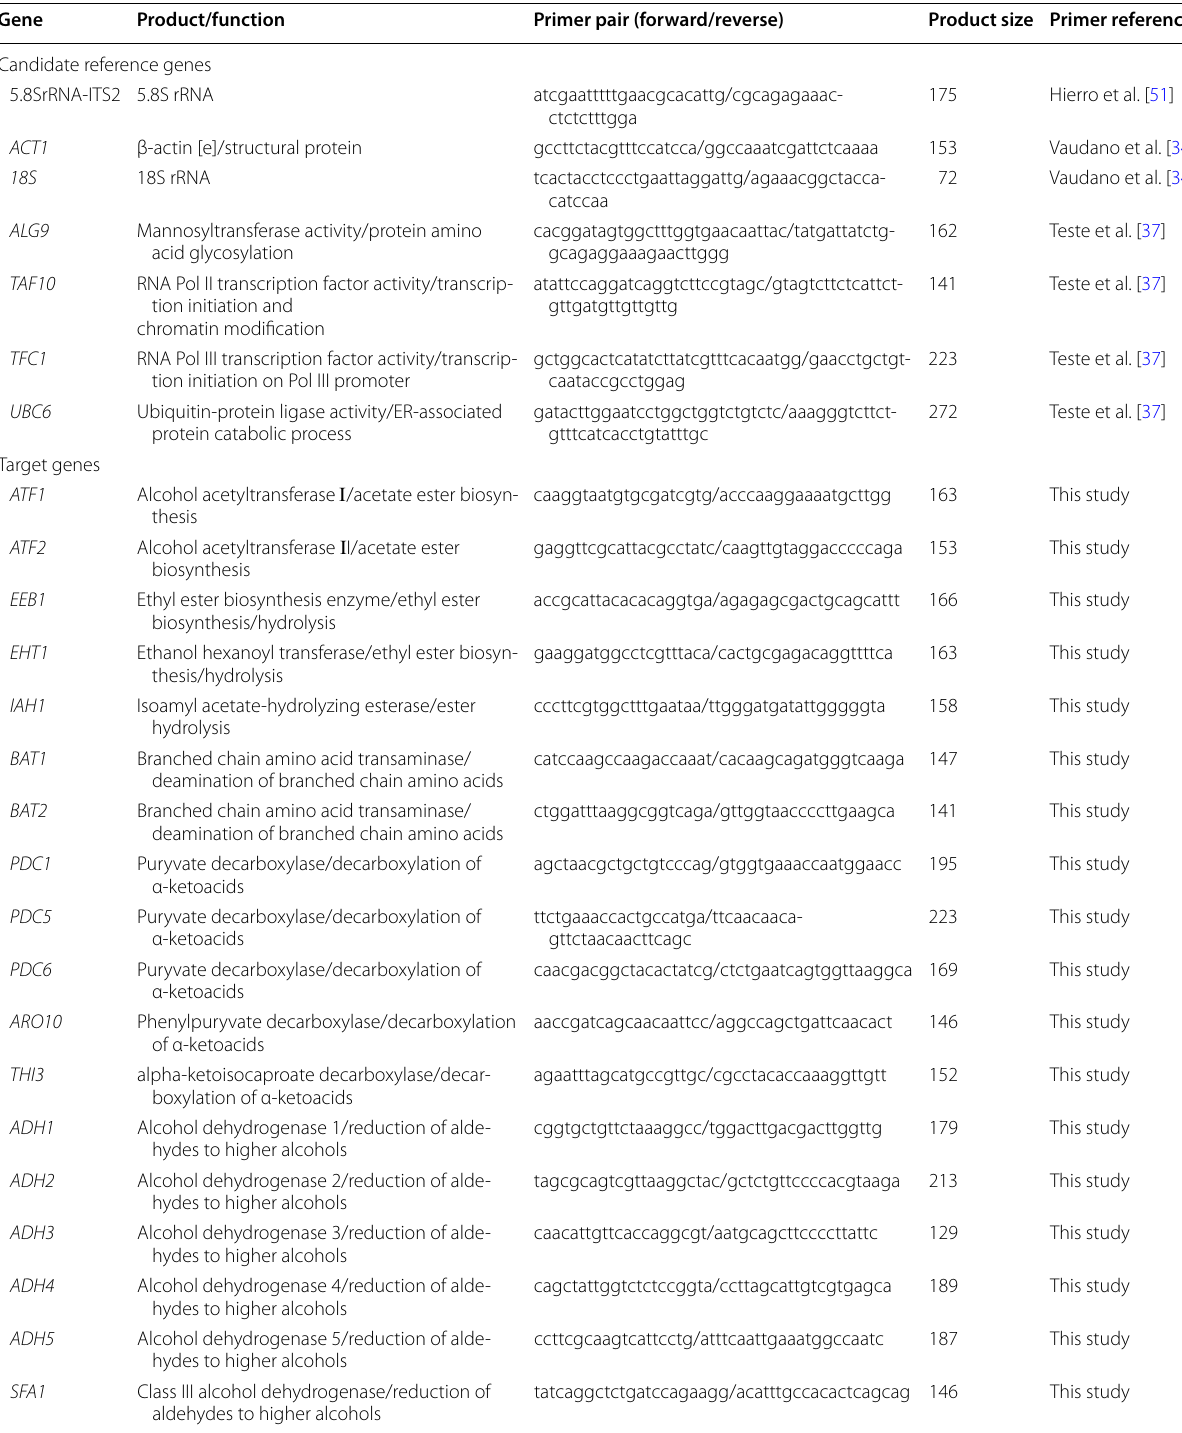
Table 2 Genes and primers used in this study